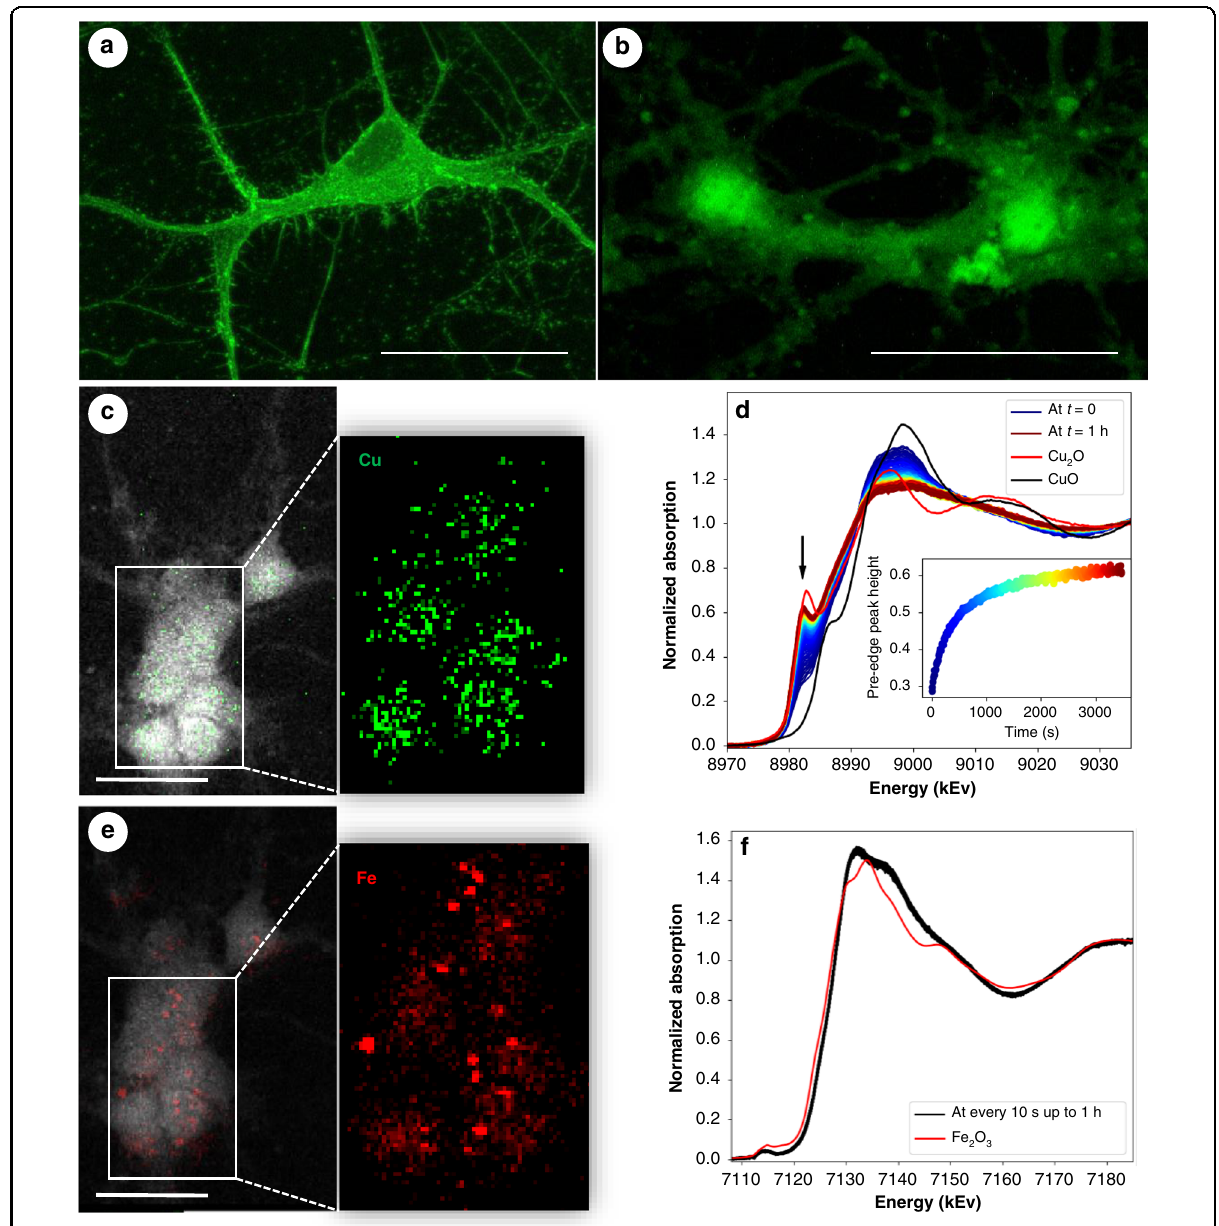
Fig. 5 Immuno fl uorescence labeling of primary neurons after S-XRF experiment. a Representative immuno fl uorescence image of primary neurons labeled with neuron-speci fi c antibody drebrin. b Drebrin immuno fl uorescence labeling of primary neurons after X-ray exposure. c , e Representative image of Cl, Cu, and Fe distributions in primary APP-KO neurons. d Photoreduction of copper during X-ray absorption measurements at room temperature. Cultured cells were incubated with 10 − 2 M CuSO 4; after a 30-min incubation, cells were washed, collected, and freeze-dried. XANES spectra were collected at room temperature. XANES spectra of Cu 2 O and CuO were used as references of Cu(I) and Cu(II), respectively. An arrow indicates the pre-edge peak at 8982.5 eV, indicative of the Cu(I) state. The inserted graph shows the dynamic of Cu photoreduction over the measurement time. f No photoreduction of iron was observed during X-ray absorption measurements at room temperature. Cultured cells were incubated with 10 − 2 M Fe 2 O 3; after a 30-min incubation at 4 °C, cells were washed, collected, and freeze-dried. XANES spectra were collected every 10 s for 1 h at room